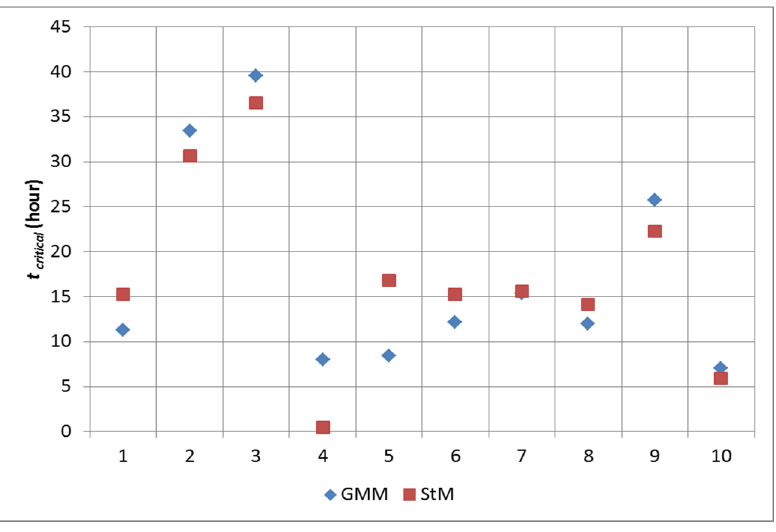
Figure 9. The critical time for CO poisoning calculated by static model no. 3.